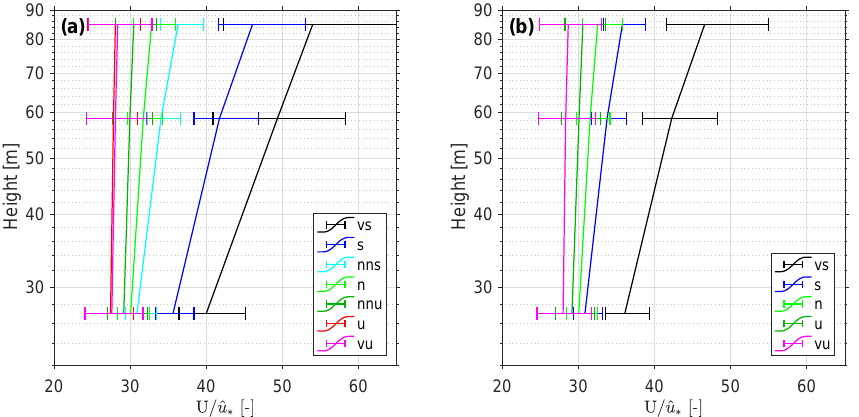
Figure 14. Median and percentiles of the u ∗ -normalized wind profiles measured by the metmast during IJmuiden campaign clustered by atmospheric stability classes. ( a ) Clusters by Gryning’s classes. ( b ) Clusters by Van Wijk’s classes. Error bars depict the 25th to 75th percentiles at each